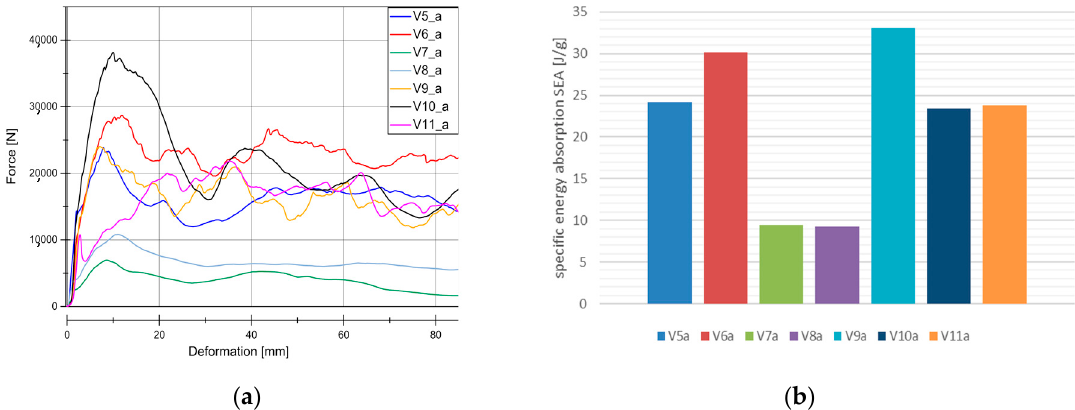
Figure 5. Results for quasic-static experiments (series “a”). ( a ) Load-Deformation curve for all the material under quasi-static conditions. ( b ) SEA for all of the material under quasi-static conditions.